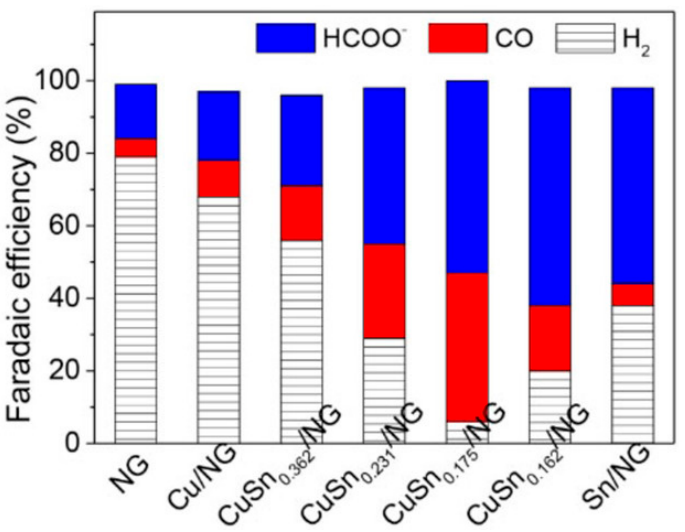
Figure 9. Faradaic efficiency of Cu-Sn NPs on NG with various ratios of Cu to Sn at − 1.0 V (vs. RHE) for the ECO 2 RR (0.5 M KHCO 3 ). Reproduced with permission [34].